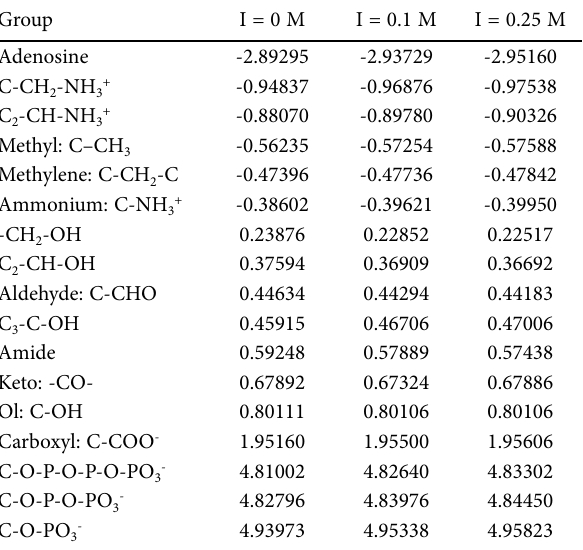
Table 3. Group contributions to aqueous irreversibility poten- tials Π’ i ° at a pressure of 100 kPa, pH = 7 and three different ionic strengths I. This table is based on the convention that Π i ° = 0 for species H + , adenosine, NAD - and NADP 3 - at zero ionic